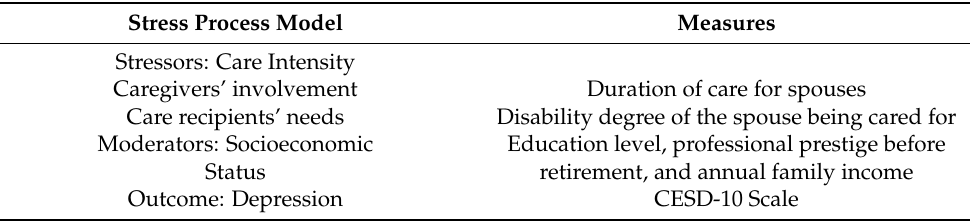
Table 2. The operationalization of key concepts of the stress process